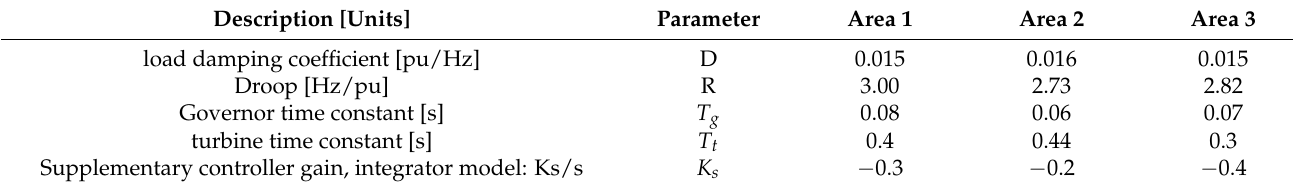
Figure 12. Block diagram of one power system area. It includes a model of the governor with frequency control loops for a non-reheat steam generator unit and e-line power change. T 12 = 0.2, T 13 = 0.25, T 23 = 0.12 pu/Hz. Table 1. Parameters used in the experiment of three control areas.